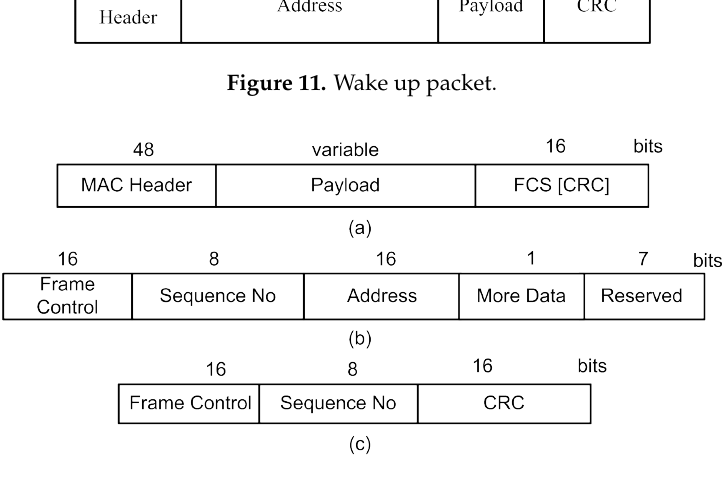
Figure 12. Frames: ( a ) MAC; ( b ) header; ( c )